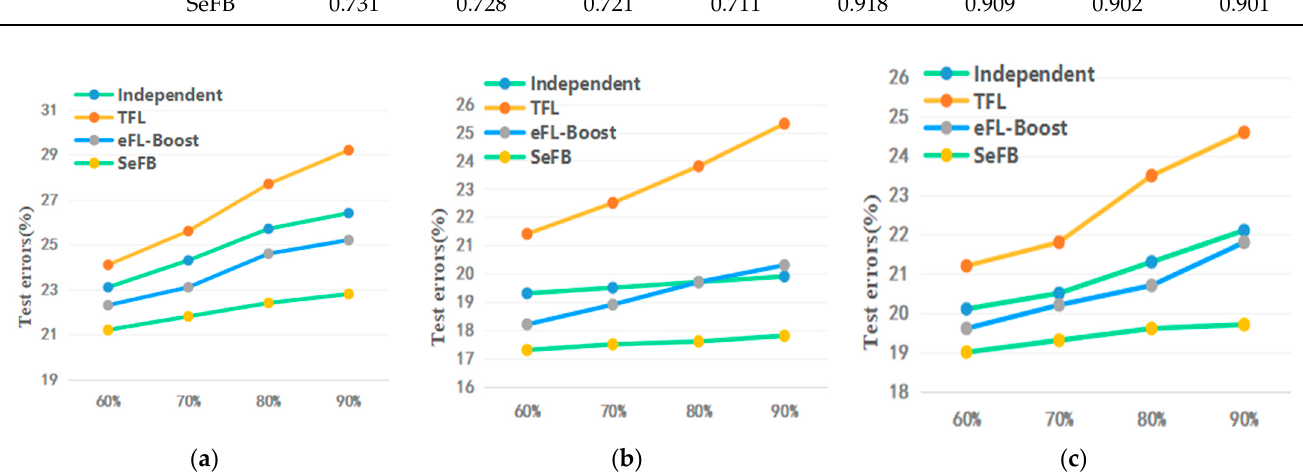
Figure 5. Impact of participants’ data imbalance ratio on Test Errors. ( a ) Credit 1 dataset, ( b ) Credit 2 dataset, ( c ) Adult dataset.